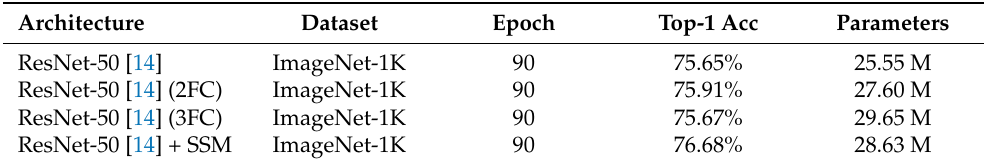
Table 4. The result of the parameter increase in ImageNet-1K. In all experiments, FC was added vertically, and all were ensembled using the averaging